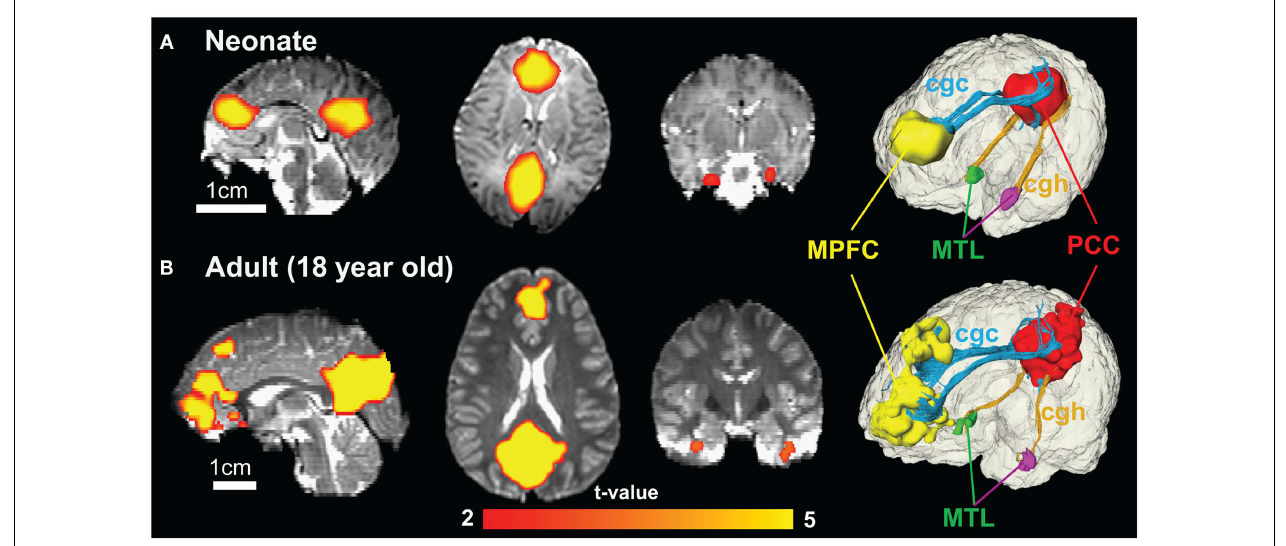
that cingulate gyrus part of cingulum (cgc) connects MPFC and PCC and cingulum hippocampal part (cgh) connects PCC and MTL for both neonate and adult brain.The 3D reconstruction of clusters at MPFC, PCC, and MTL was directly extracted from rs-fMRI